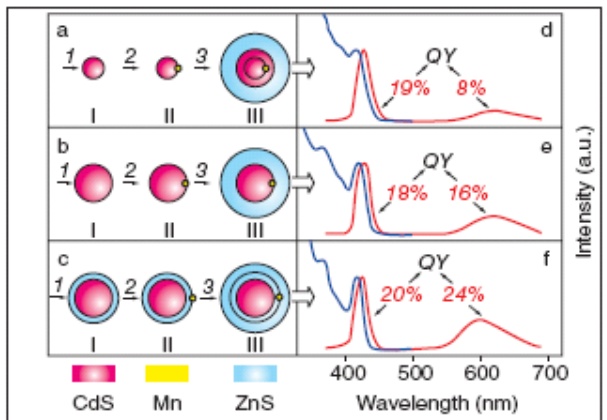
Figure 3. Differences in optical properties of Mn-doped CdS/ZnS core/shell Qdots with different Mn positions; (a) doped in CdS core, (b) at interface of the core/shell structure, and (c) in ZnS shell structure. Core diameter was 3.8 nm and ZnS shell thickness was 1.5